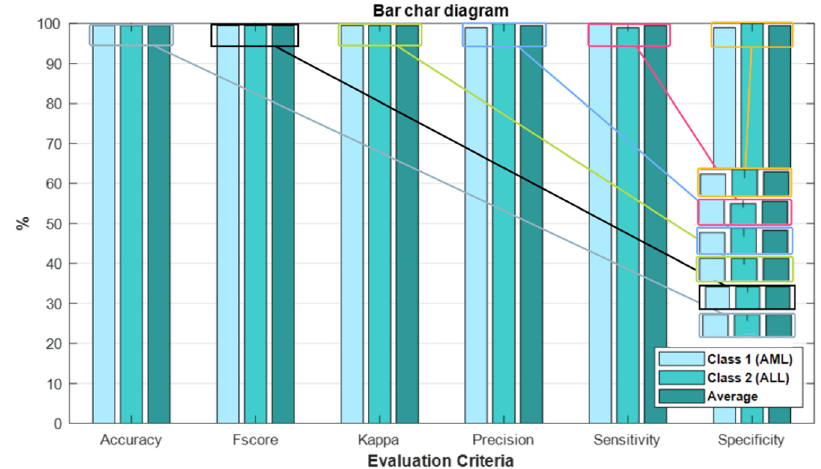
Figure 9. The bar chart plots accuracy, fscore, kappa, precision, sensitivity, and specificity based on